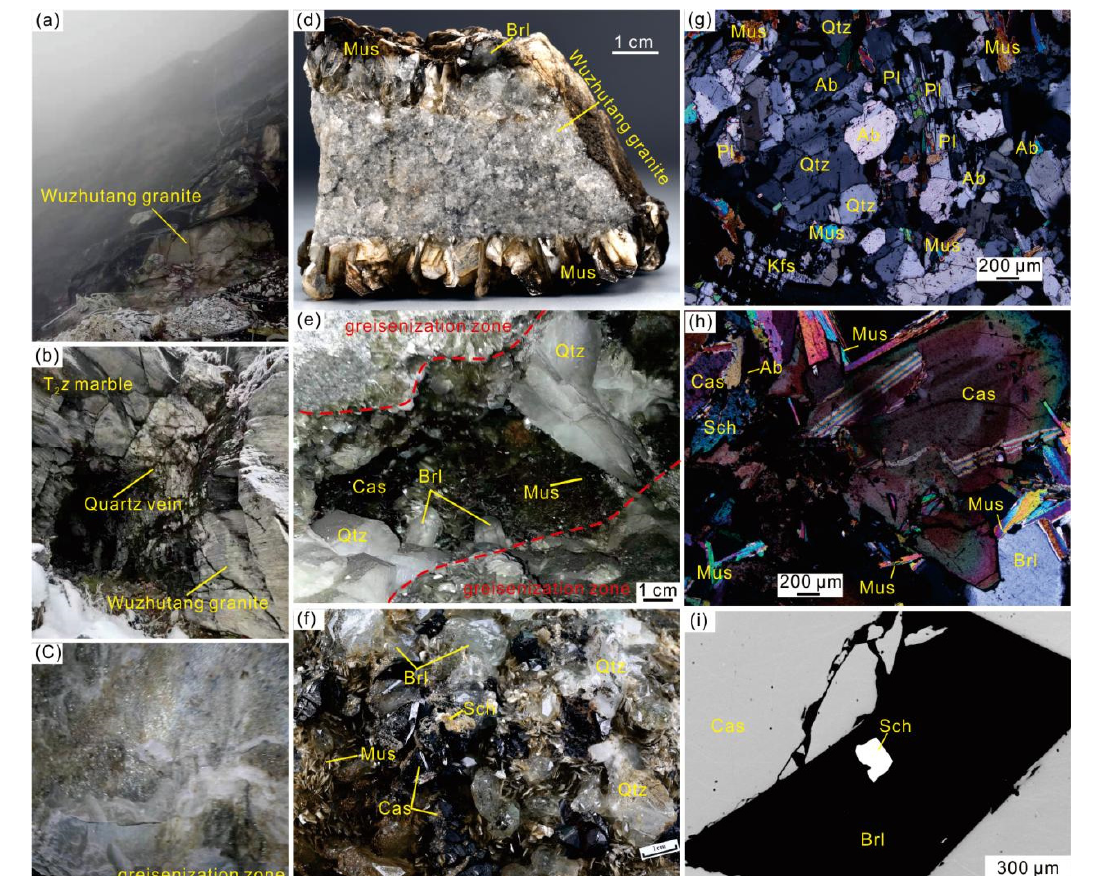
Figure 3. ( a ) Wuzhutang granite from the Xuebaoding mining area, Sichuan Province, China. ( b ) Wuzhutang granite and marble from the Middle Triassic Zagunao Formation (T and W–Sn–Be quartz vein in adit PD03 from the Xuebaoding mining area). ( c ) Greisenization zone of the Wuzhutang granite in adit PD03 from the Xuebaoding mining area. ( d ) Monzogranite and quartz vein bearing beryl, cassiterite, and scheelite from the Wuzhutang granite. ( e ) Planar greisenization in the ore-bearing quartz vein in the crystal cave structure in adit PD03. ( f ) Beryl and cassiterite ores with coarse euhedral crystals. ( g ) Microscopic characteristics of monzogranite. ( h ) Microscopic character- istics of the quartz vein bearing beryl, cassiterite, and scheelite. ( i ) Backscattered electron image of the quartz vein beryl, cassiterite, and scheelite. Abbreviation: Ab—Albite, Brl—Beryl, Cas—Cassit-